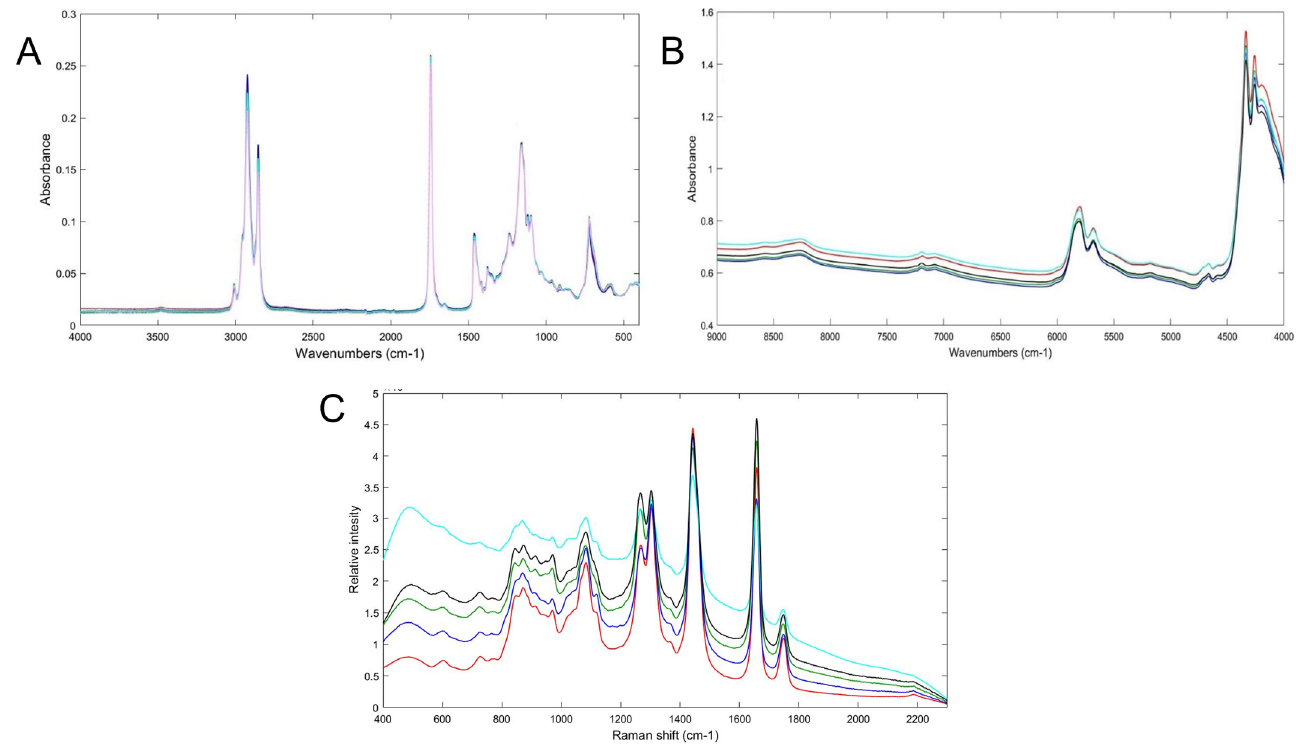
Figure 2. ( A ) FT ‐ MIR, ( B ) FT ‐ NIR and ( C ) Raman spectra of pure Argan oil (red/pink), corn oil (green), rapeseed oil (sky blue), sunflower oil (black) and peanut oil (blue). Spectra measured by authors.